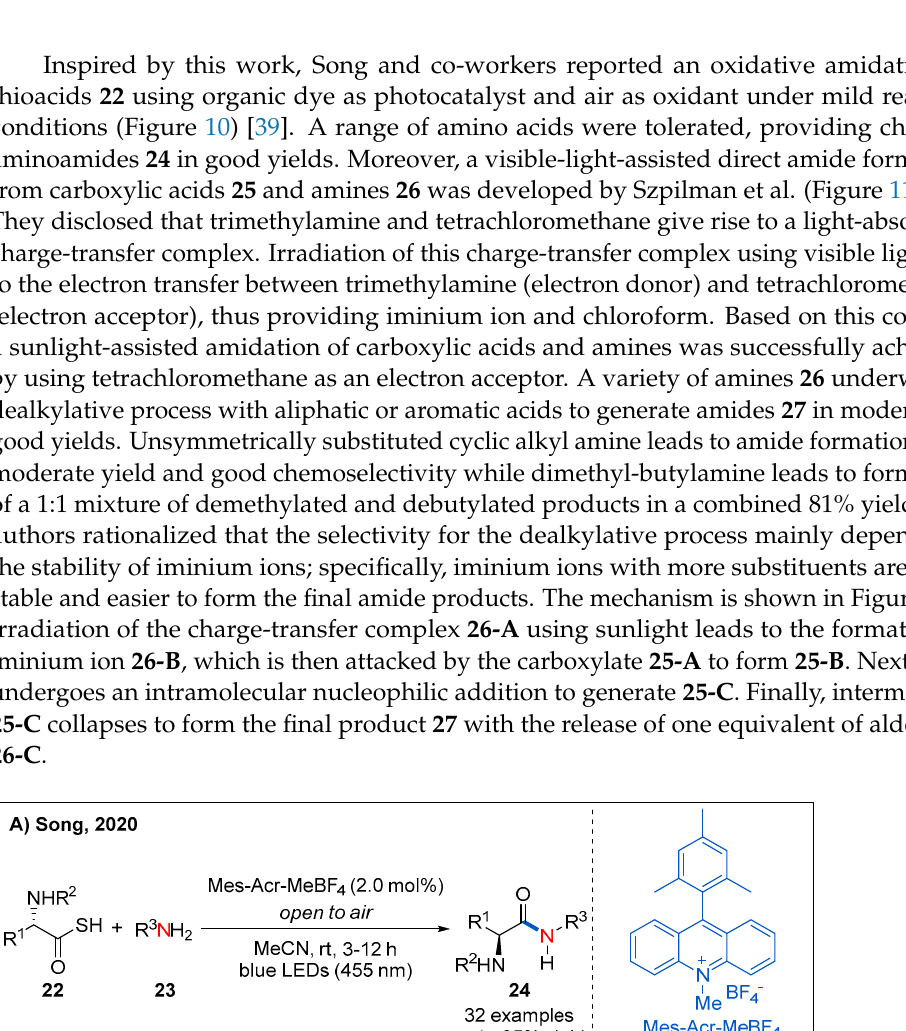
Figure 11. Sunlight-assisted direct dealkylative amide formation via a charge-transfer complex. 2.6. From Alkynes Reactions involving C ≡ C triple bond cleavage is of great challenge in the construction of targeted molecules in organic synthesis. In 2016, Hwang’s group described a novel and effective copper-catalyzed aerobic oxidative C–N coupling via C ≡ C triple bond cleavage under visible light irradiation was (Figure 12) [41]. A wide range of substrates, including various terminal alkynes 28 and electron-deficient 2-aminopyridines 29 were well-toler- ated (Figure 12B). The mechanistic investigation revealed that the copper(II)-superoxo or -peroxo complex is probably responsible for the oxidative cleavage of C ≡ C triple bonds of terminal alkynes. Based on a series of mechanistic experiments, a plausible mechanism was proposed (Figure 12C). In situ-generated copper(I) phenylacetylide 28-A reaches ex- cited state via ligand to metal charge transfer (LMCT) under irradiation of blue LEDs. Then, the photo-excited Cu(I)-phenylacetylide 28-B undergoes a SET process with O 2 to